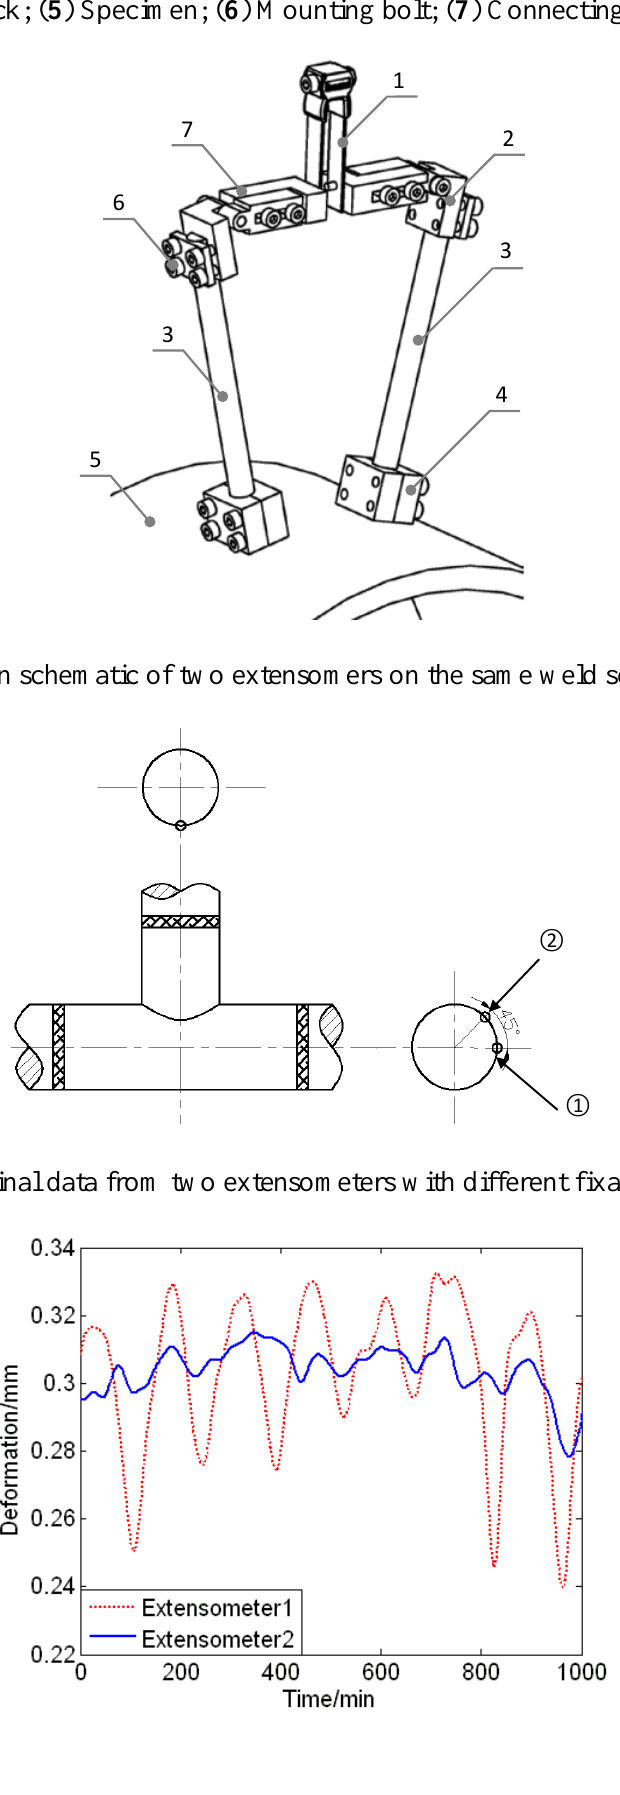
Figure 6. Structure of the extensometer. ( 1 ) Sensor; ( 2 ) Fixing mechanism; ( 3 ) Ceramic rod; ( 4 ) Position block; ( 5 ) Specimen; ( 6 ) Mounting bolt; ( 7 ) Connecting mechanism.